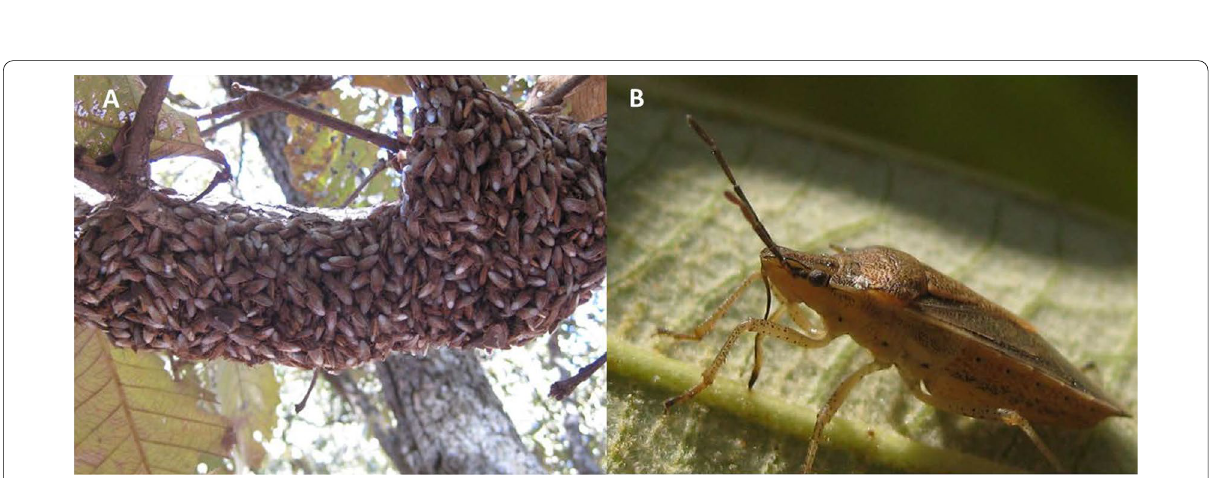
Fig. 2 Behavior of Oebalus mexicana in hibernation sites. A Swarms of bugs on branches of Quercus sp. B Adult feeding on a Quercus sp. leaf. Zináparo hill, Michoacán, México.